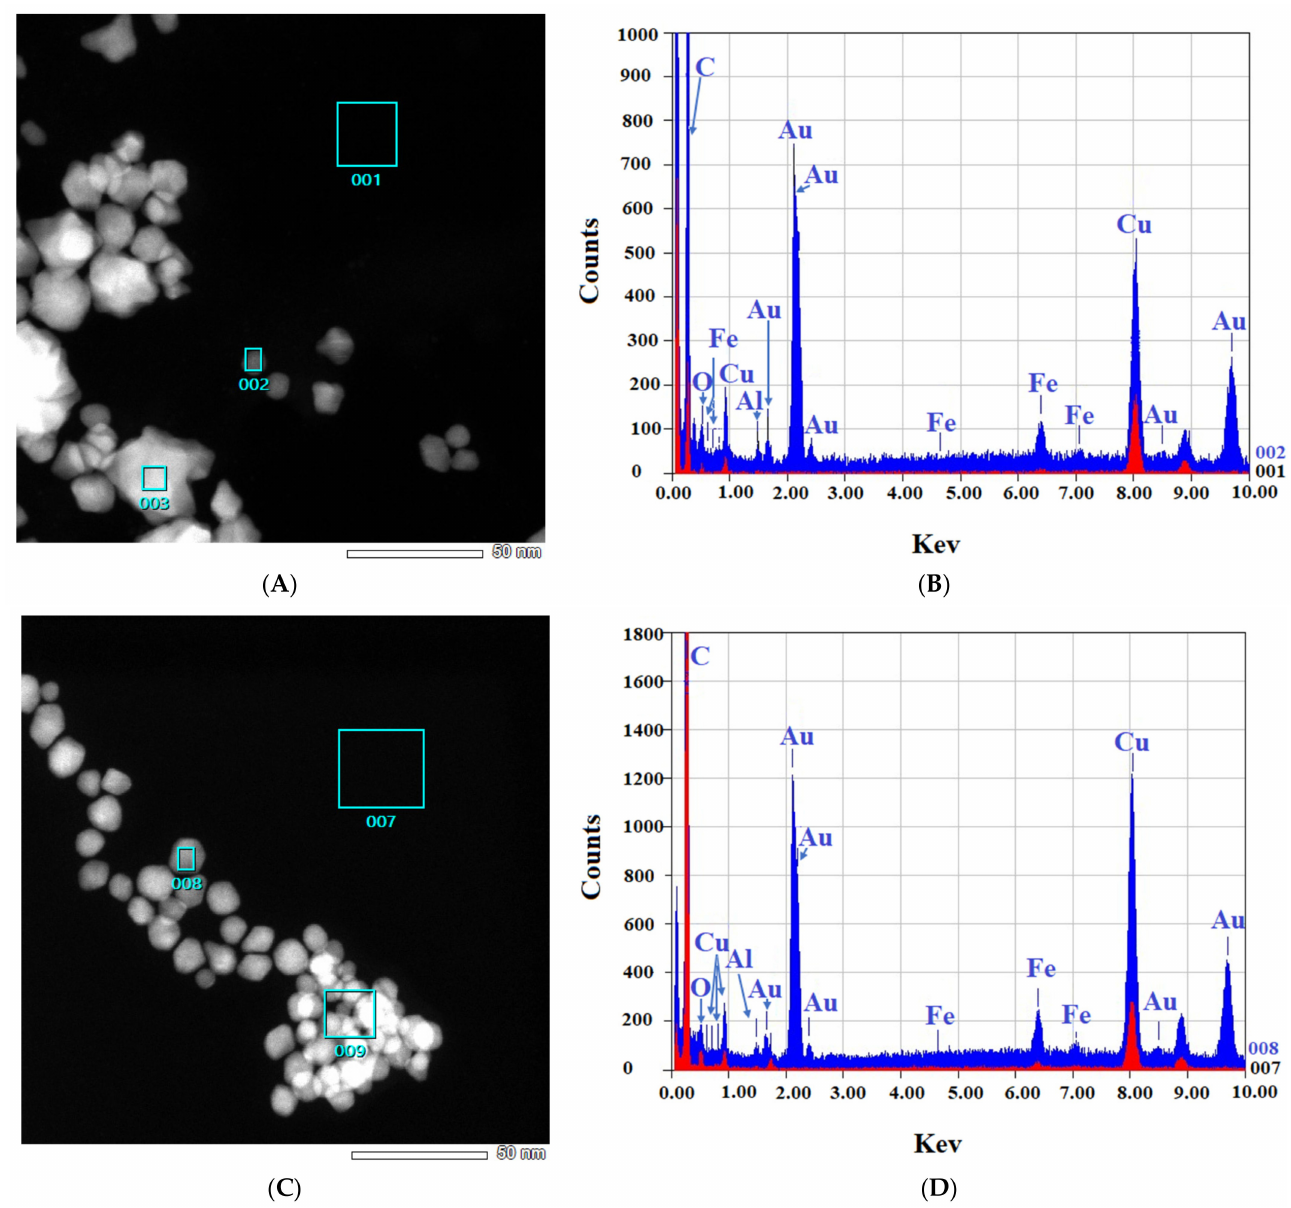
Figure 4. EDS-obtained images of “cold” and “hot” AuNP samples. ( A , B ): Obtained images from the “cold” sample. ( C , D ): Obtained images from the “hot” sample. (Scale bars = 50 nm). The spectra for the background (red) and AuNPs (blue) reveal the